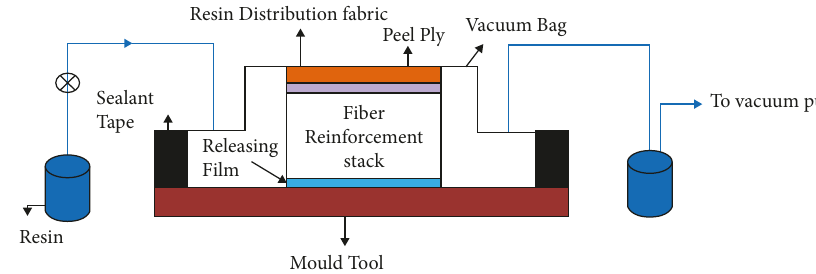
Figure 4: The schematic diagram of VARTM.